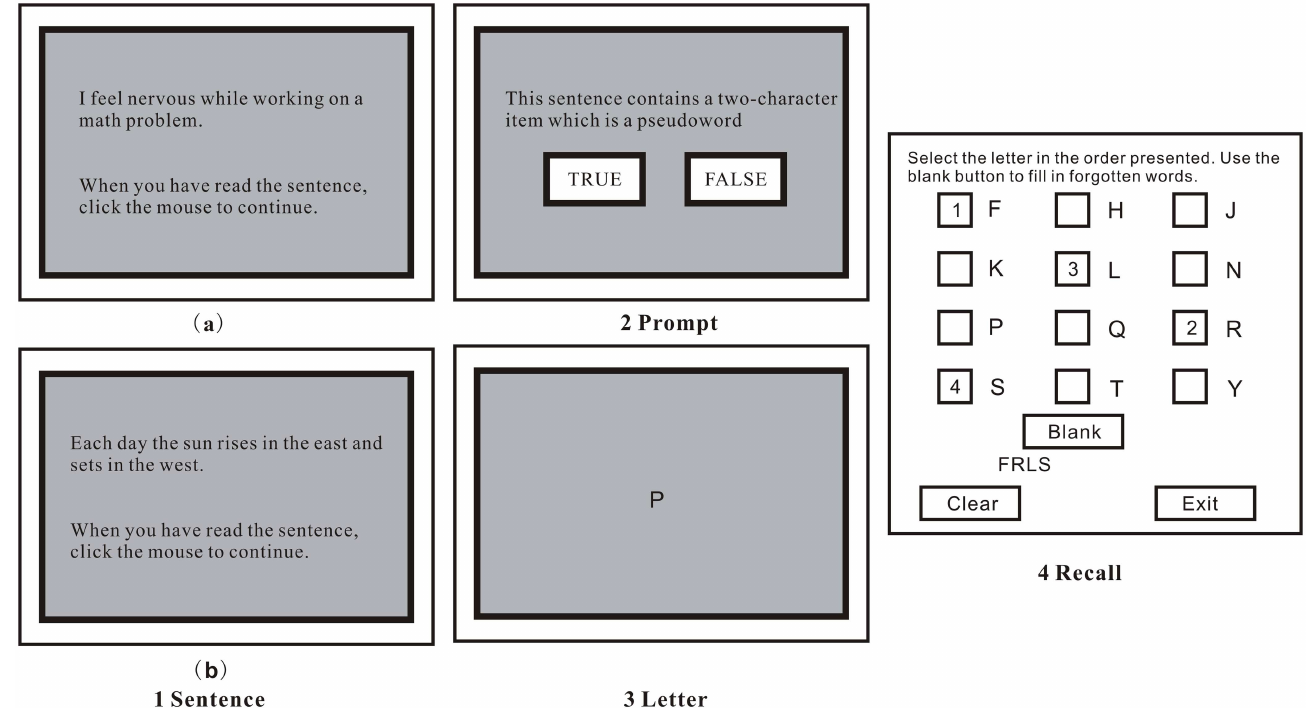
Fig 1. Illustration of the modified RS task. (1) A sentence(a math-related sentence[1a] or an emotionally-neutral sentence [1b]) is presented. (2) After participants read the sentence aloud, they clicked the mouse and a prompt was presented,which was judgedto be “false” or “true”. (3) This was followedby a letter for 800 ms. (4) For recall, the correct letters from the current set are selected in the correct